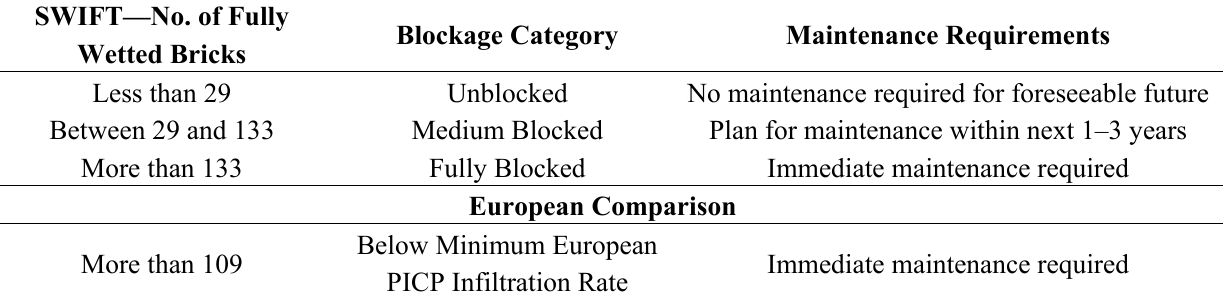
Table 2. Suggested PICP maintenance requirements for SWIFT test